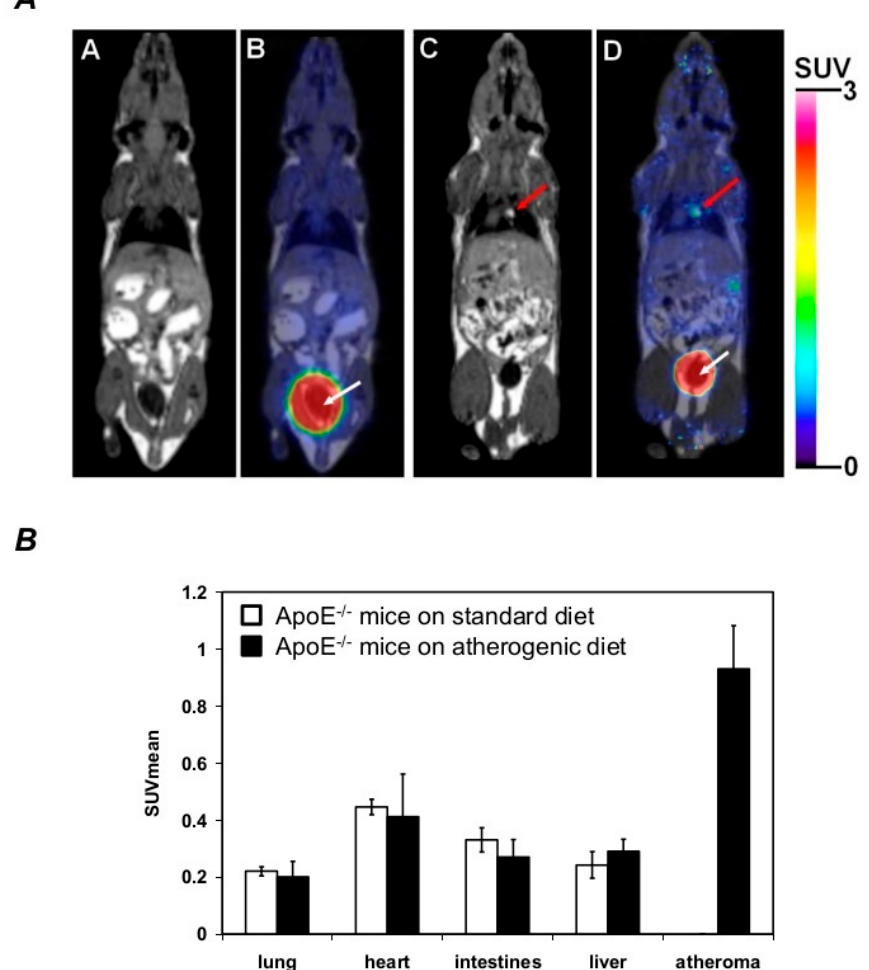
Figure 6. DFC accumulates within the atheromatous plaque of aorta in ApoE − / − mice. ApoE − / − mice were maintained on an atherogenic diet ( n = 5) for 8 weeks to develop atheromatous plaques within the aorta. For control ApoE − / − mice were on a standard diet ( n = 5) for 8 weeks. 68 Ga-DFC was administered for both ApoE − / − mice kept on an atherogenic diet and ApoE − / − mice on a standard diet via the lateral tail vein. ( A ) After administration of 68 Ga-DFC, representative T1-weighted MRI and coregistered PET-MRI images of ApoE − / − mice on an atherogenic diet are shown in Panel C and D, respectively. Scale bar: 1 cm. ( A ) Representative T1-weighted MRI and coregistered PET-MRI images of ApoE − / − mice on a standard diet treated with 68 Ga-DFC are shown in Panels A and B, respectively. Red arrows indicate atheroma of aortic arch; white arrows indicate bladder with urine. ( B ) Quantitative analysis of PET / MRI images of heart, lung, intestines, liver and atheromas at 30 min of intravenous injection of 68